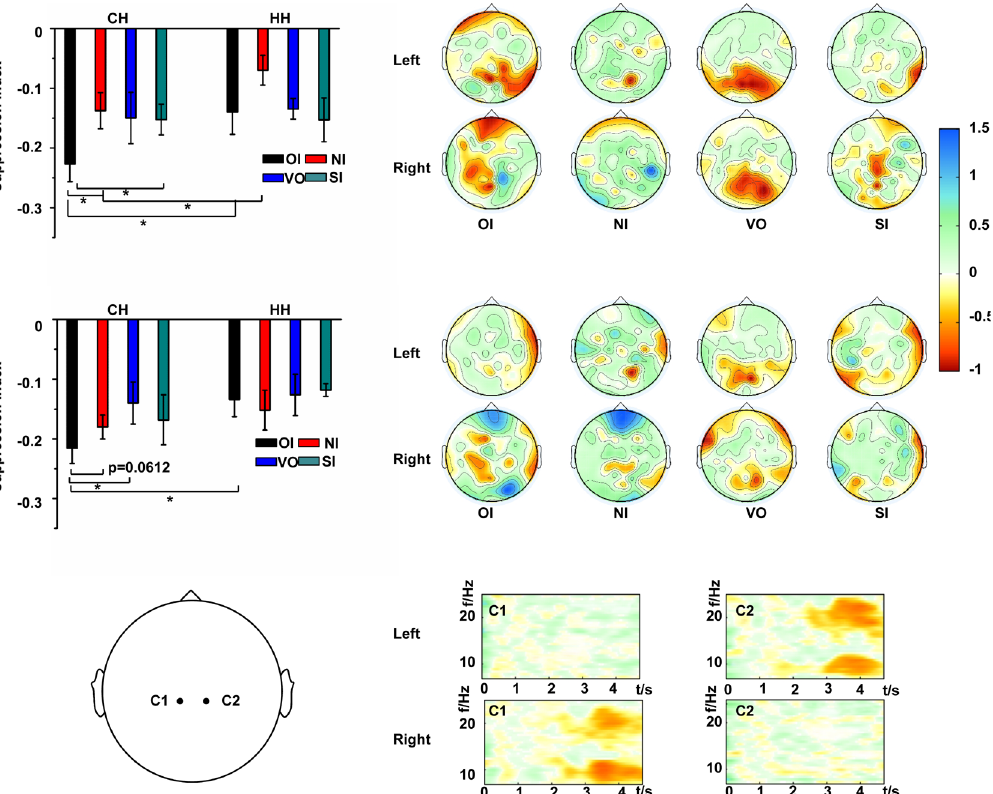
Fig 5. Suppression for perception conditions. (a) Statistical suppression index and topographical views in mu rhythm. (b) Statistical suppression index and topographical views in beta rhythm. (c) ERD/ERS maps of OI on subject 3 at C1 and C2. The X axis indicates time (seconds). Participants image from t = 3 s to t = 4.7 s. The Y axis indicates frequency (Hz). CH and HH indicate contralateral and ipsilateral hemispheres. Left and right indicate the direction of the cue at t = 2 s.